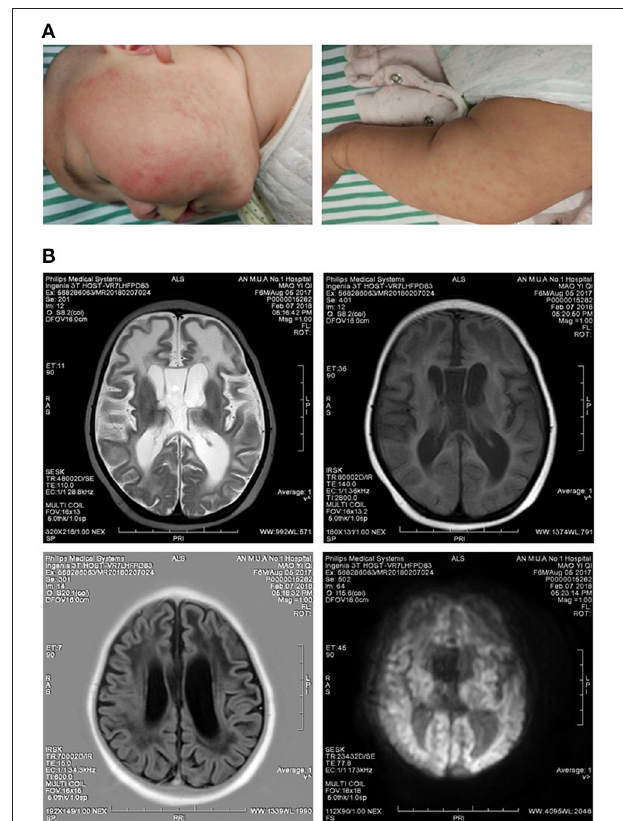
FIGURE 1 | Clinical symptoms of the patient. (A) Mild rashes on the skins of the face and legs. (B) Slightly longer T1 and T2 signals were observed in the frontotemporal white matter, and the volume of white matter was decreased. Ventricles were enlarged, and sulci were widened.